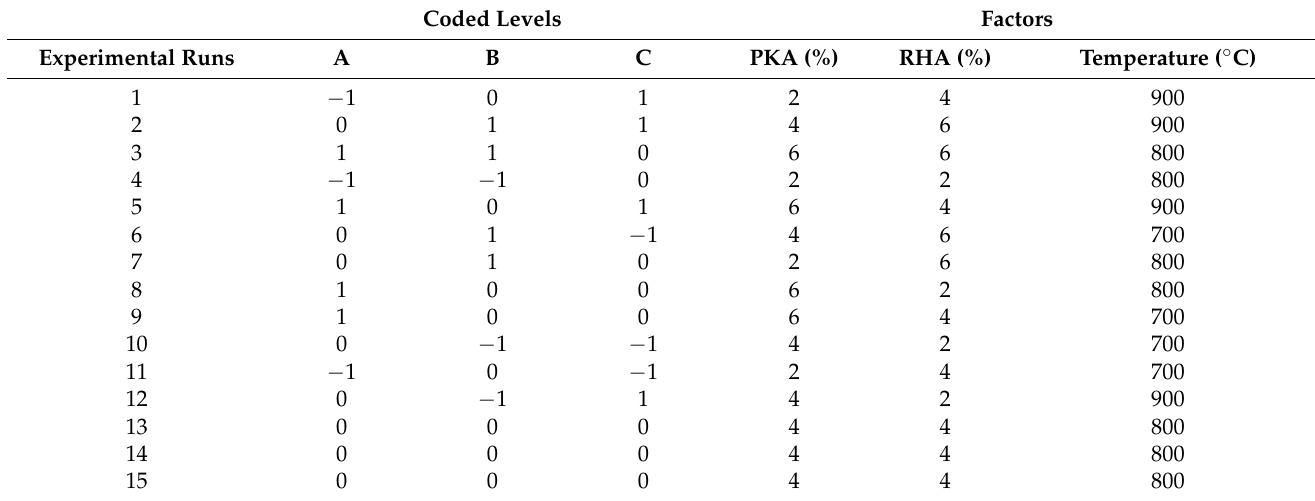
Table 2. Mix design according to the experimental